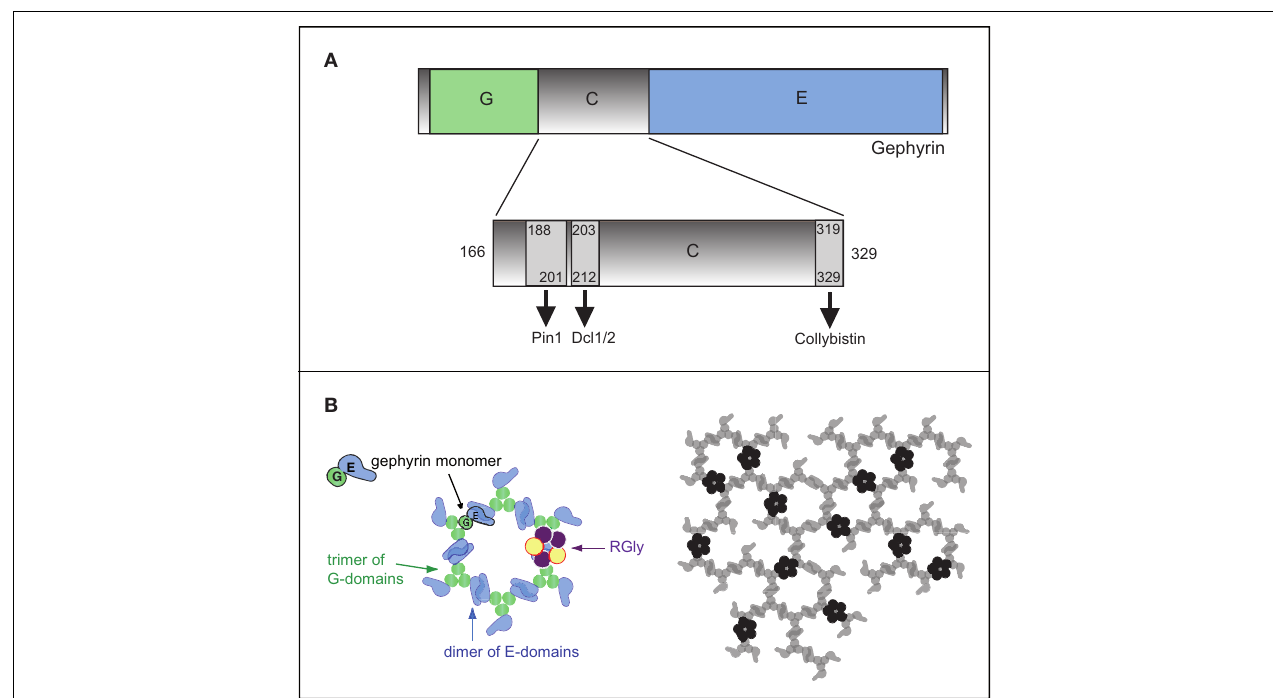
gephyrin protein. (B) The gephyrin «hexagonal lattice» oligomerization model: E-and G-gephyrin domains are able to dimerize and trimerize, respectively (left panel). Combination of these two properties would lead to a hexagonal structure of gephyrin (right panel) underneath the postsynaptic membrane, where GlyR (in black) would anchor itself through the binding of the intracellular loop of the beta subunit with the E-domain of